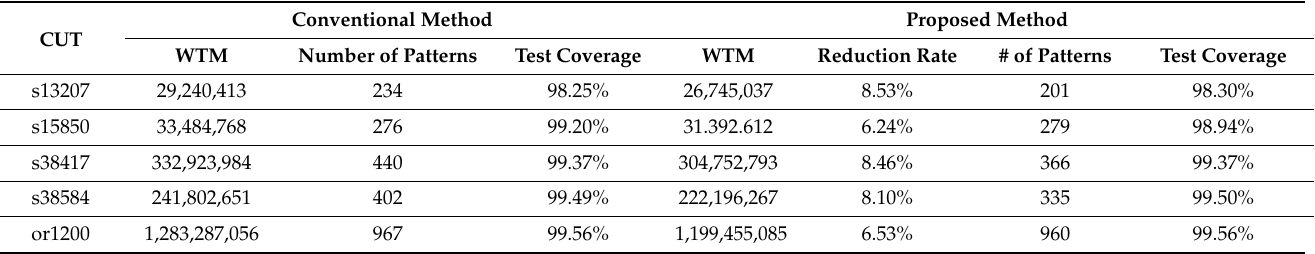
Table 6. Comparison of power consumption with the test